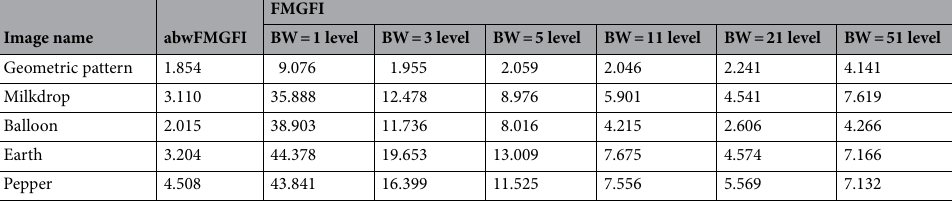
Table 13. Comparison of the RMSE values of each sample image filtered using the variable level of BW of FMGFI (regarding edge preservation performance).